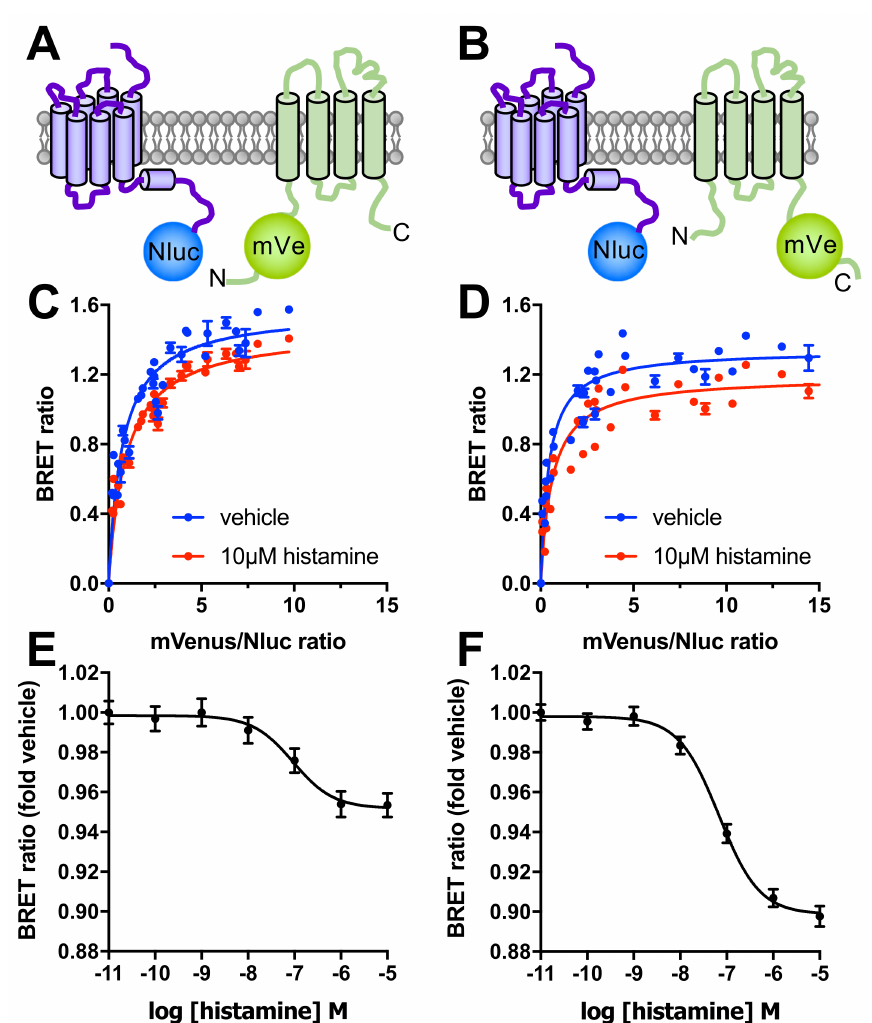
Figure 3. Detection of close proximity between H 4 R and TSPAN4 in HEK293T cells by BRET. ( A , B ) In frame fusion of the bioluminescent enzyme to the C-terminus of H 4 R and mVenus to either the intracellular N- or C-terminal tail (panels A , B , respectively) of TSPAN4 allows BRET detection of their proximity in cells co-expressing these constructs. ( C , D ) Saturation BRET curves measure the BRET ratio between H 4 R-Nluc and either ( C ) mVenus-TSPAN4 or ( D ) TSPAN4-mVenus as function of increasing mVenus/Nluc ratios under basal conditions (vehicle in blue) and upon stimulation with 10 µ M histamine (red). Saturation BRET data are displayed as mean ± SD from 3 independent experiments performed in triplicate ( E , F ) Effect of increasing concentrations histamine on the basal interaction between H 4 R-Nluc and either ( E ) mVenus-TSPAN4 or ( F ) TSPAN4-mVenus. Data are displayed as mean ± SEM from 5 independent experiments performed in